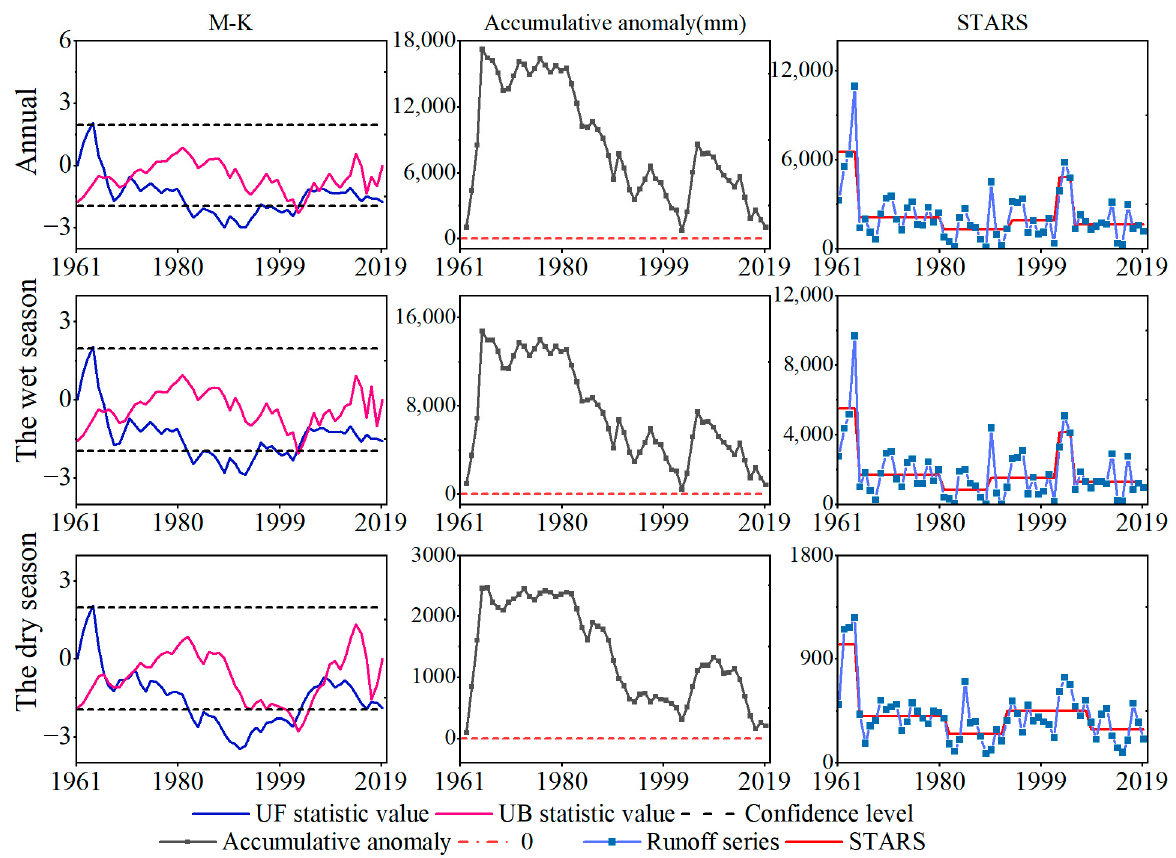
Figure 7. The mutation analysis of the runoff at Beiwang station.